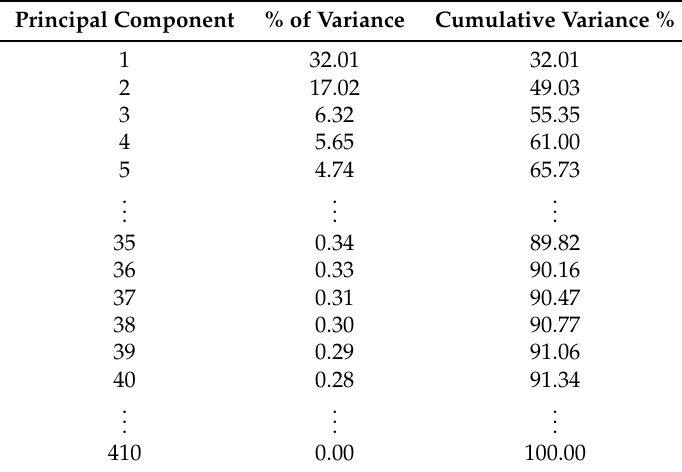
Principal Component % of Variance Cumulative Variance